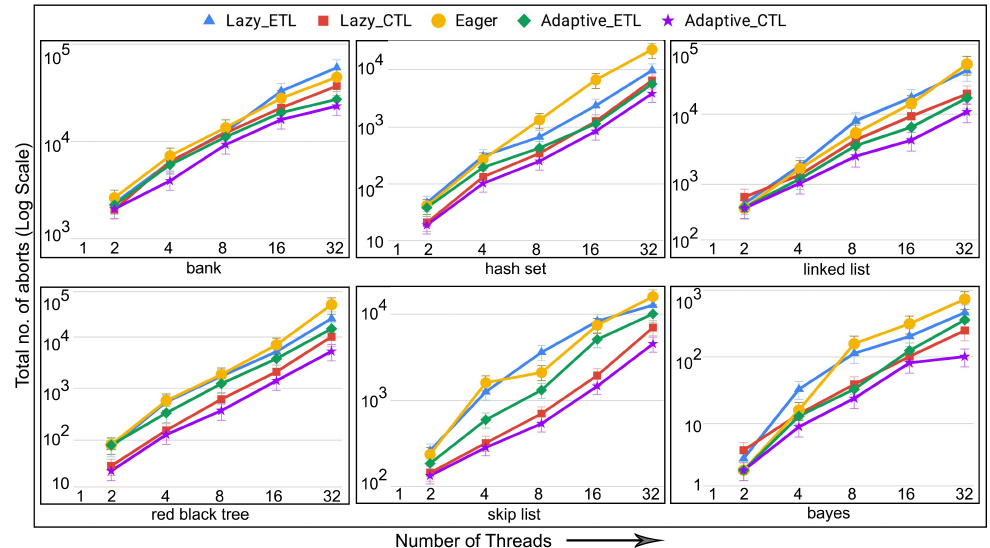
Figure 20. Number of aborts in micro-benchmarks and bayes from STAMP using better time barrier in non-persistent TM.